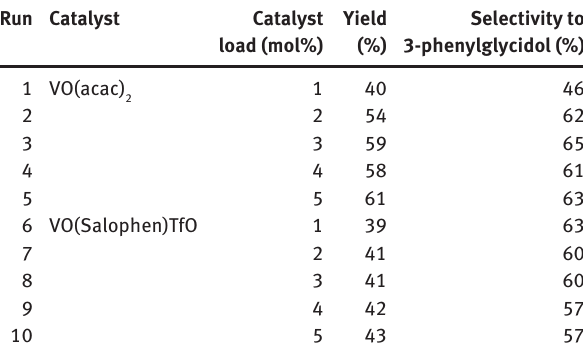
, (B) VO(Salophen)TfO. 2